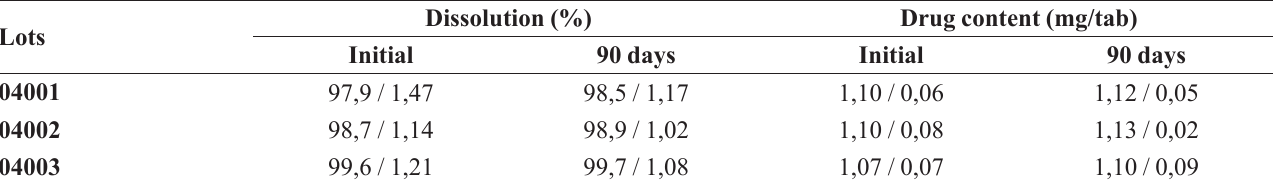
TABLE II - Results of the study of photostability Lots